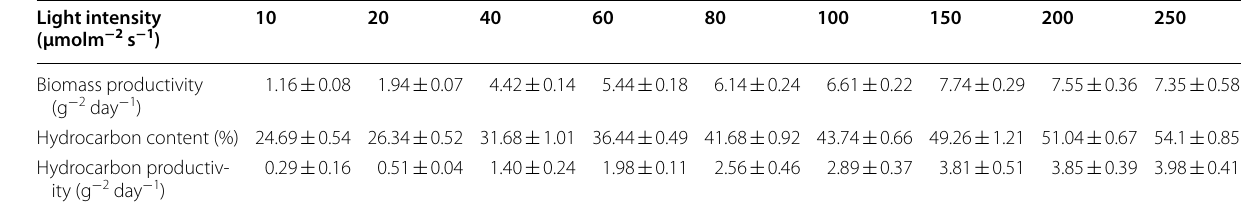
The data were means